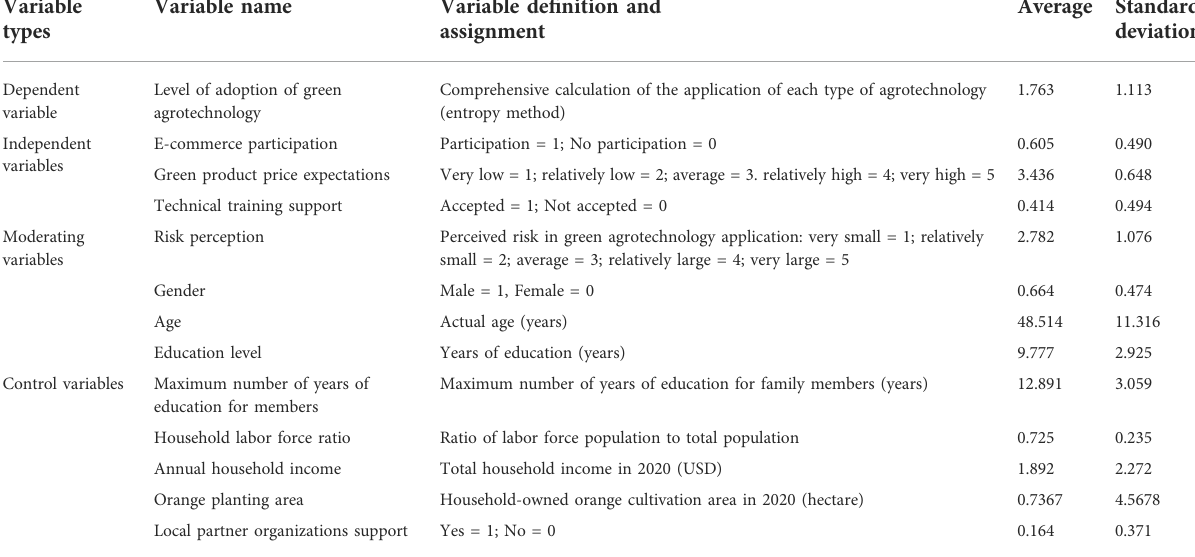
TABLE 3 De fi nition of variables and descriptive statistics.